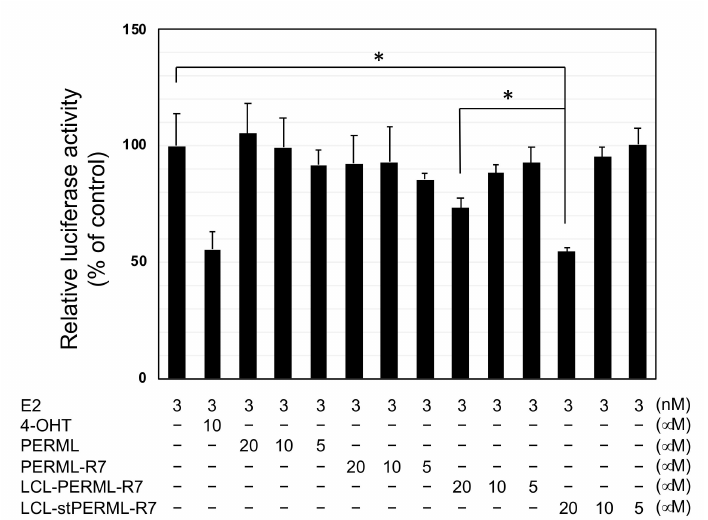
Figure 5. Luciferase reporter assay of PERML, PERM-R7, LCL-PERM-R7 and stPERML-R7. Data are presented as means with standard deviations ( n = 3). MCF-7 cells were transiently transfected with the luciferase reporter plasmid containing three tandem copies of the estrogen-response element and control Renilla luciferase plasmid-SV40. After 48 h, luciferase activity in cell lysates was measured and normalized to the Renilla luciferase activity. The relative luciferase activity was normalized by designating the activity of the E2-stimulated control condition (column 1) as 100%. 4-OHT was used as a reference inhibitor for estrogen/ER α mediated gene expression. * p < 0.05 in a two-tailed Student’s t-test. Abbreviation: E2; 17 β -estradiol, 4-OHT;